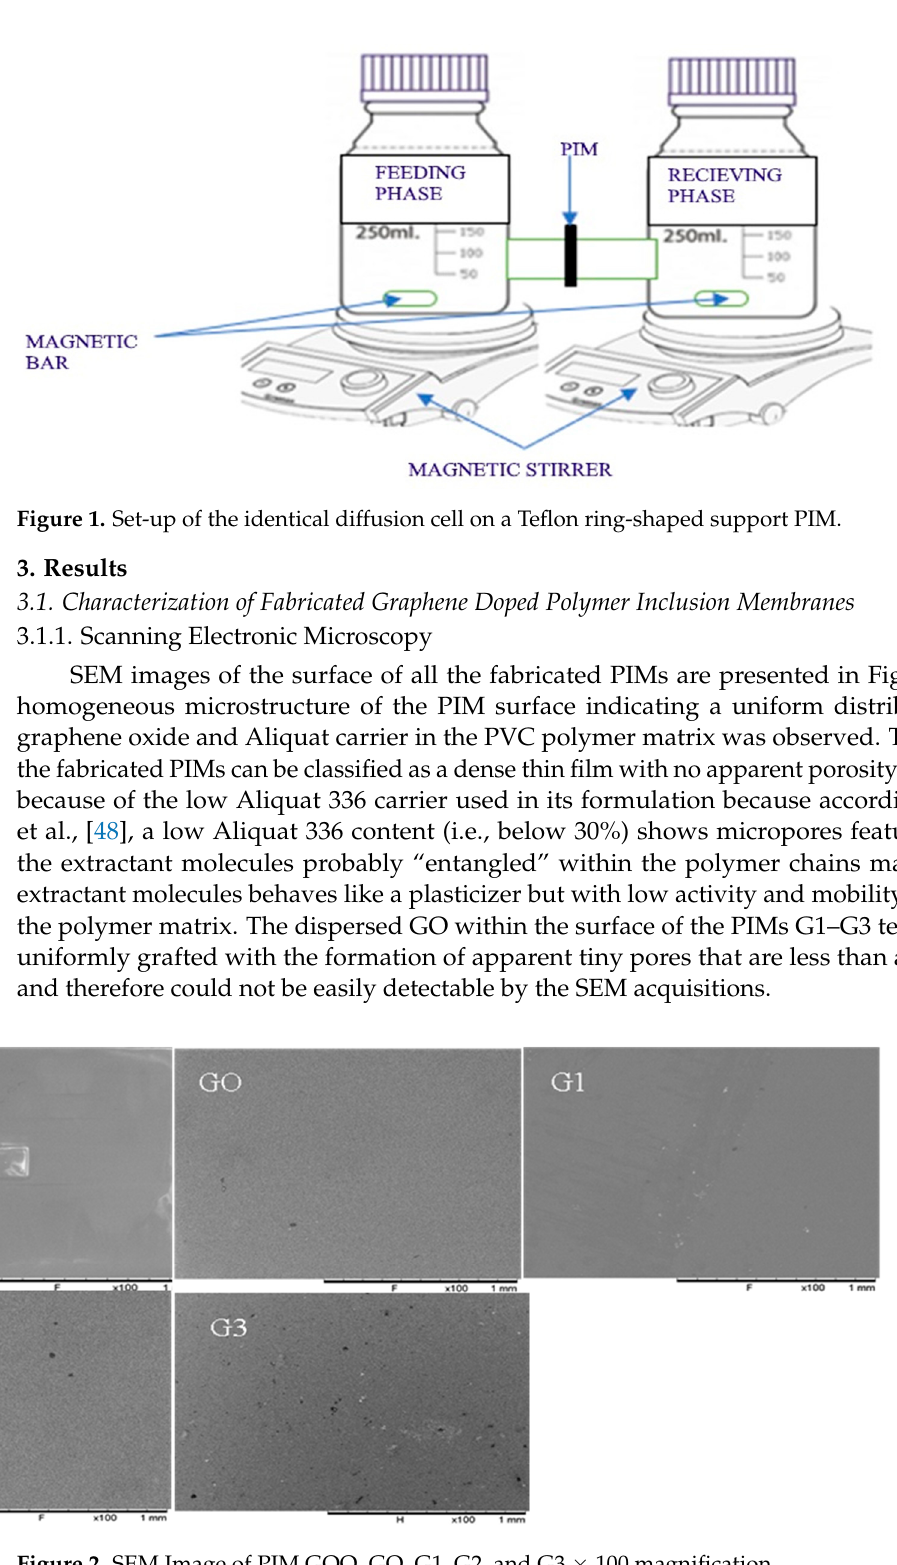
Figure 2. SEM Image of PIM GOO, GO, G1, G2, and G3 × 100 magnification.